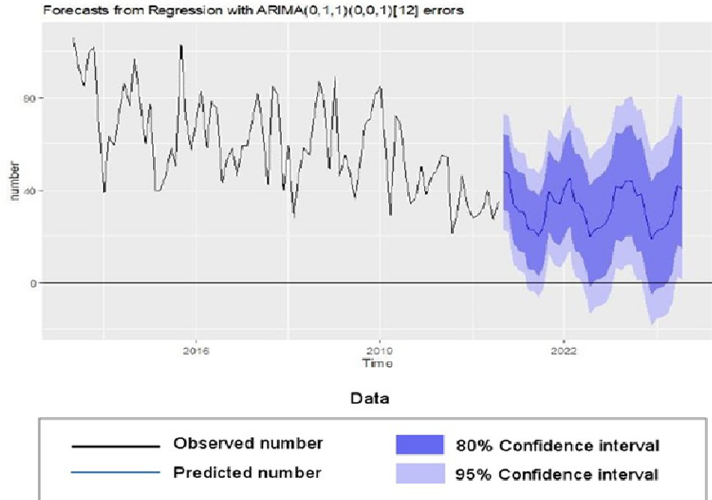
Fig 4. Forecasting the number of cutaneous leishmaniasis in Kerman province, Iran up to